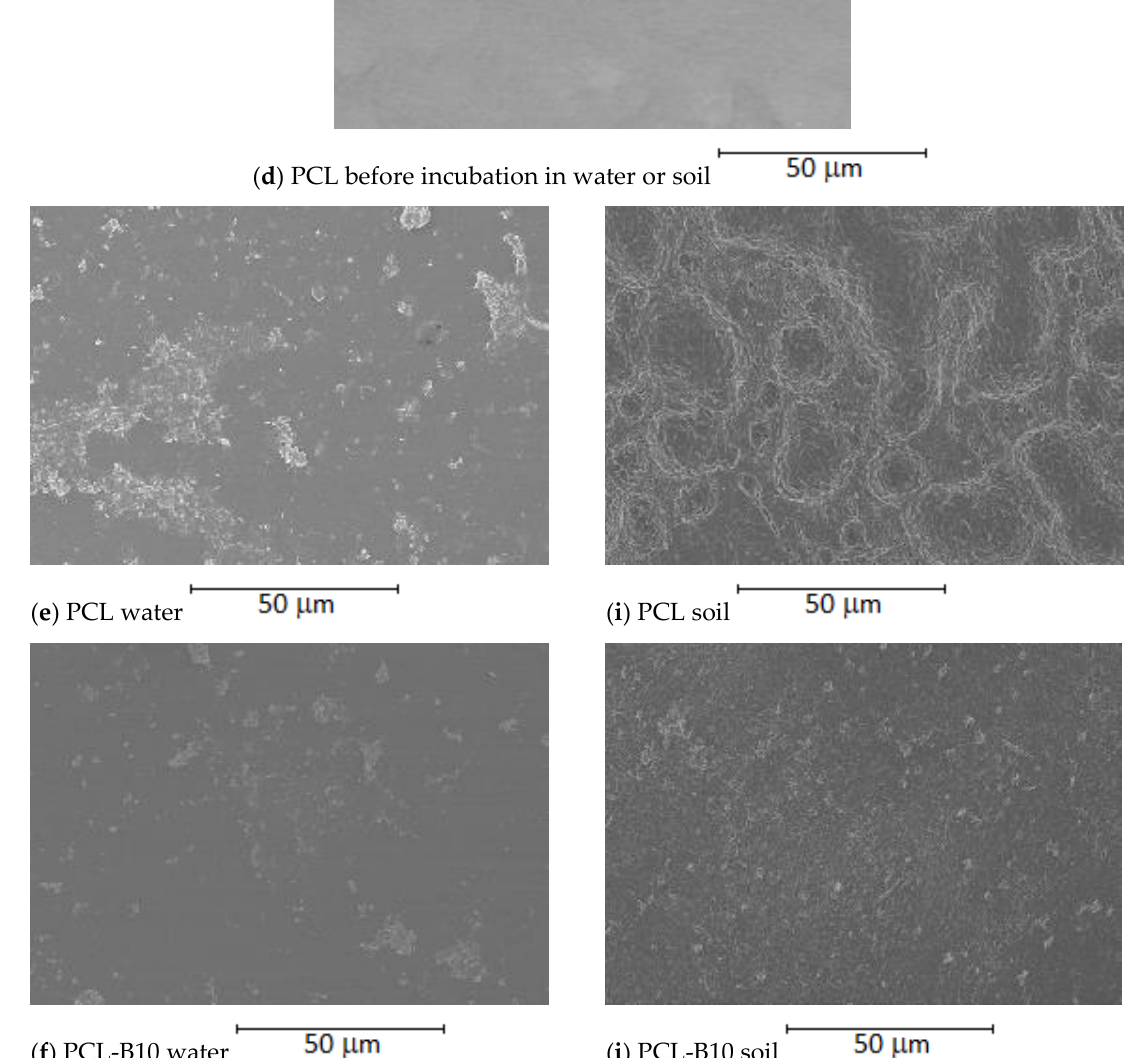
Figure 5. The biofilms formed on the surface of polymers and polymers with tar before biodegradation ( a , d ) and after biodegradation in water ( b , c , e , f ) and ( g – j ) in soil. 2.2.3. The Effect of Birch Tar Embedded into PLA and PCL on Bacterial Enzymatic Ac-